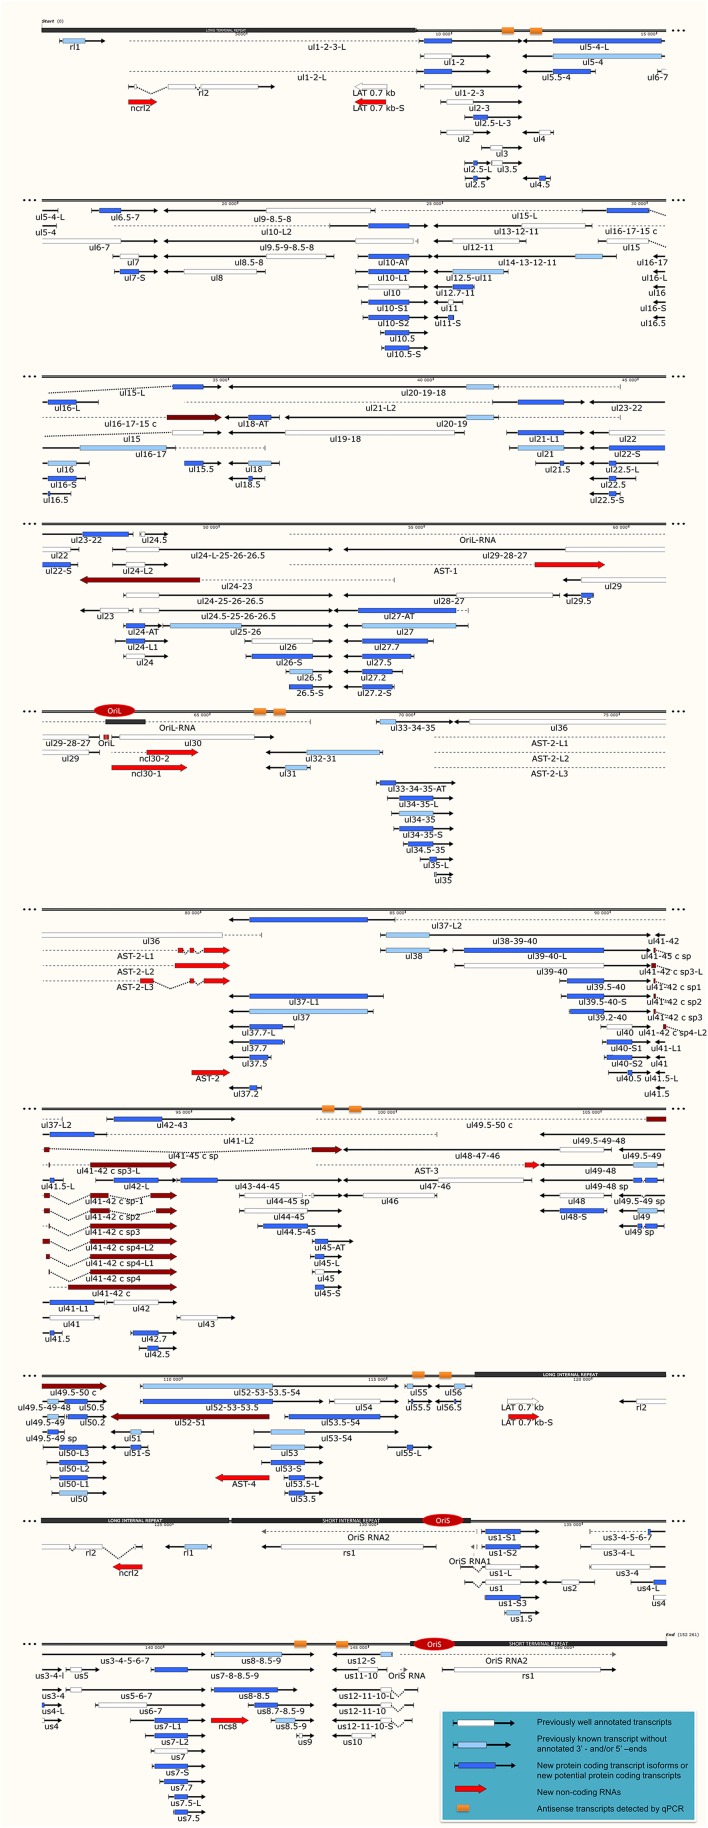
The transcriptome of the herpes simplex virus. The current version of the HSV-1 genome is composed of 115 protein-coding genes and 19 putative non-coding RNAs. The coding transcripts identified earlier are depicted as arrow-rectangles with white boxes (indicating the ORFs), the previously known transcripts (without annotated TSS and TES positions) are illustrated as light blue arrow-rectangles. The novel potential protein coding genes are labeled by dark blue rectangular arrows. The already identified lncRNAs are represented as dark-gray arrow lines, while the novel putative lncRNAs are depicted as red arrow lines. The novel polycistronic transcripts are indicated with dark blue rectangular arrows. The dark-red rectangular arrows show complex transcripts. The long black boxes represent the repeat regions of the HSV genome; red ovals represent the three replication origins. Abbreviations within the name of the transcripts: S, short TSS variant; L, long TSS variant; AT, alternative TES variant.